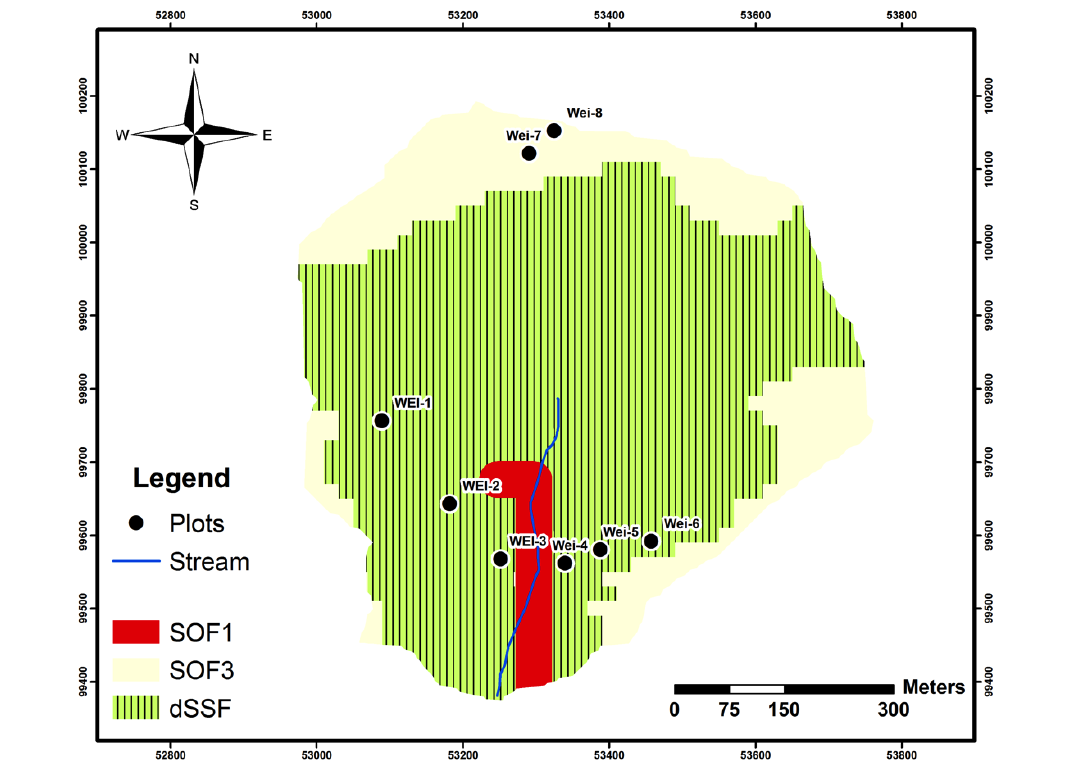
Figure 12. GIS-DRP-map Weierbach